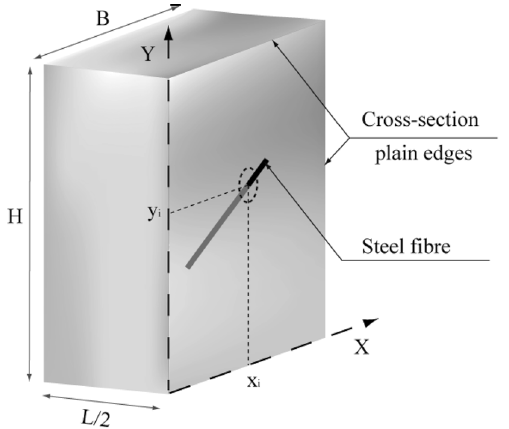
Fig. 3. Steel fibre cut-through point on the cross-section surface of composite space The method of calculating the coordinates of fibre cut-through points on the cross-section surface is illus- trated in Fig. 4.